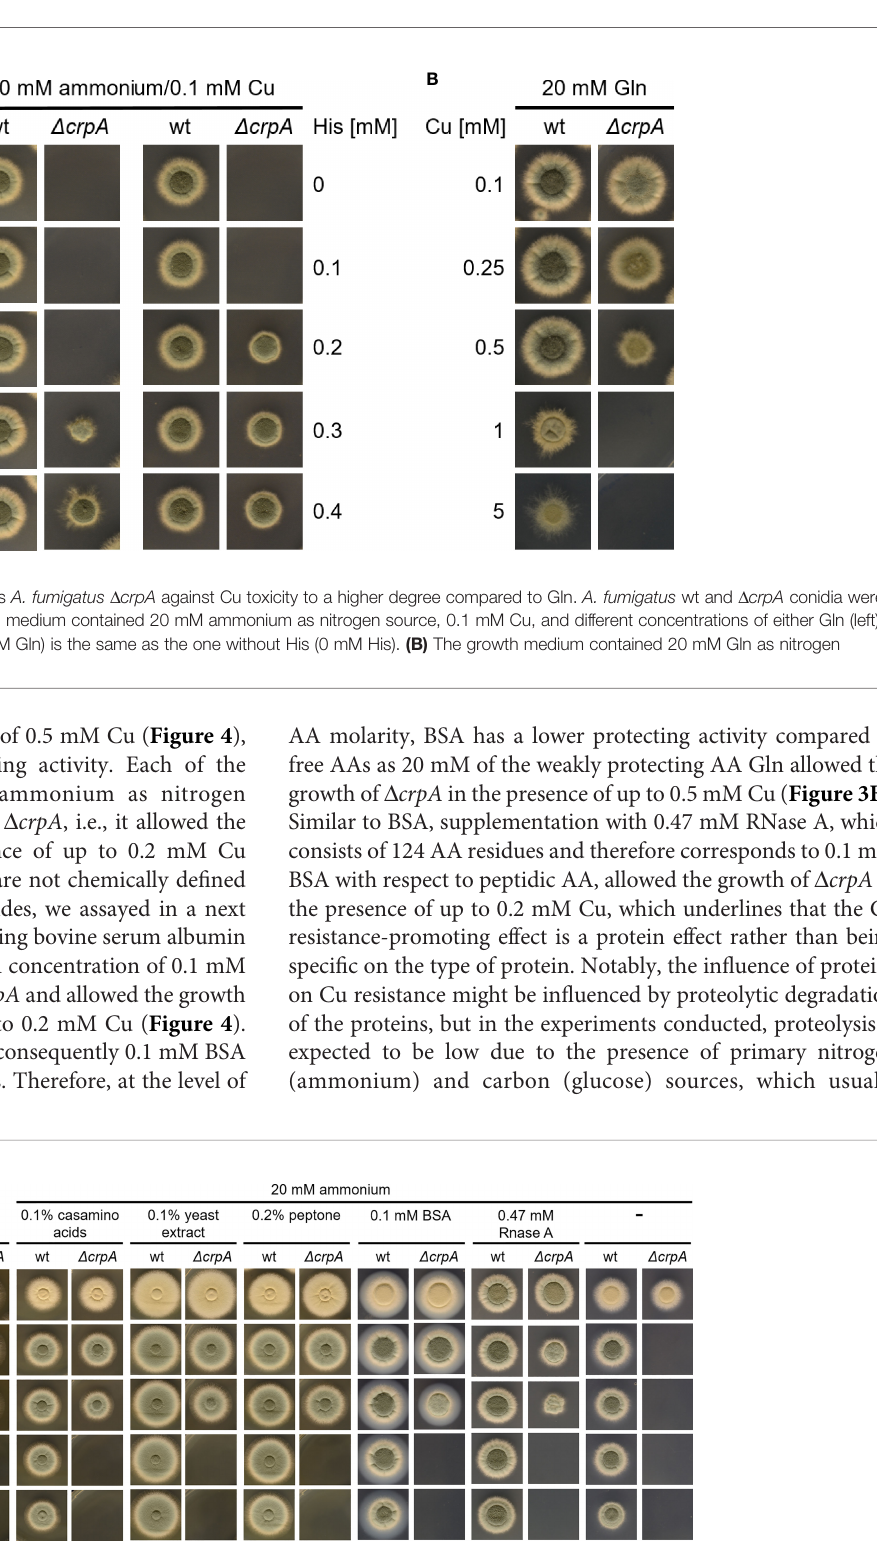
FIGURE 4 | The complex medium ingredients casamino acids, yeast extract, and peptone as well as proteins protect A. fumigatus D crpA against Cu toxicity. A. fumigatus wt and D crpA conidia were point-inoculated on solid CM or AMM with ammonium as nitrogen source and supplemented with 0.1% casamino acids, 0.1% yeast extract, 0.2% peptone, or 0.1 mM BSA and different Cu amounts. The CM plates were incubated for 30 h at 37°C and the AMM plates for 48 h at